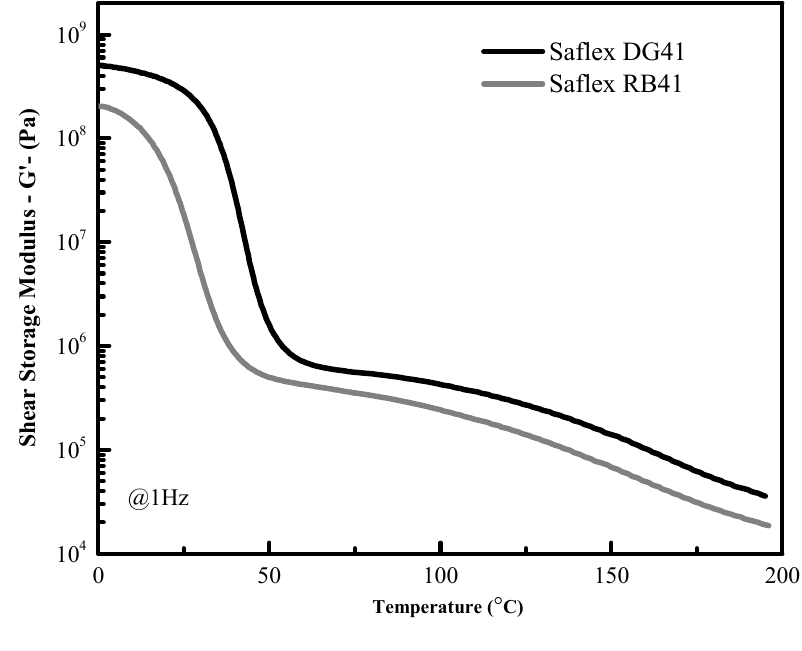
Fig. 3 Shear storage modulus of Standard and Structural PVB (Saflex ® RB41 and Saflex ® DG41